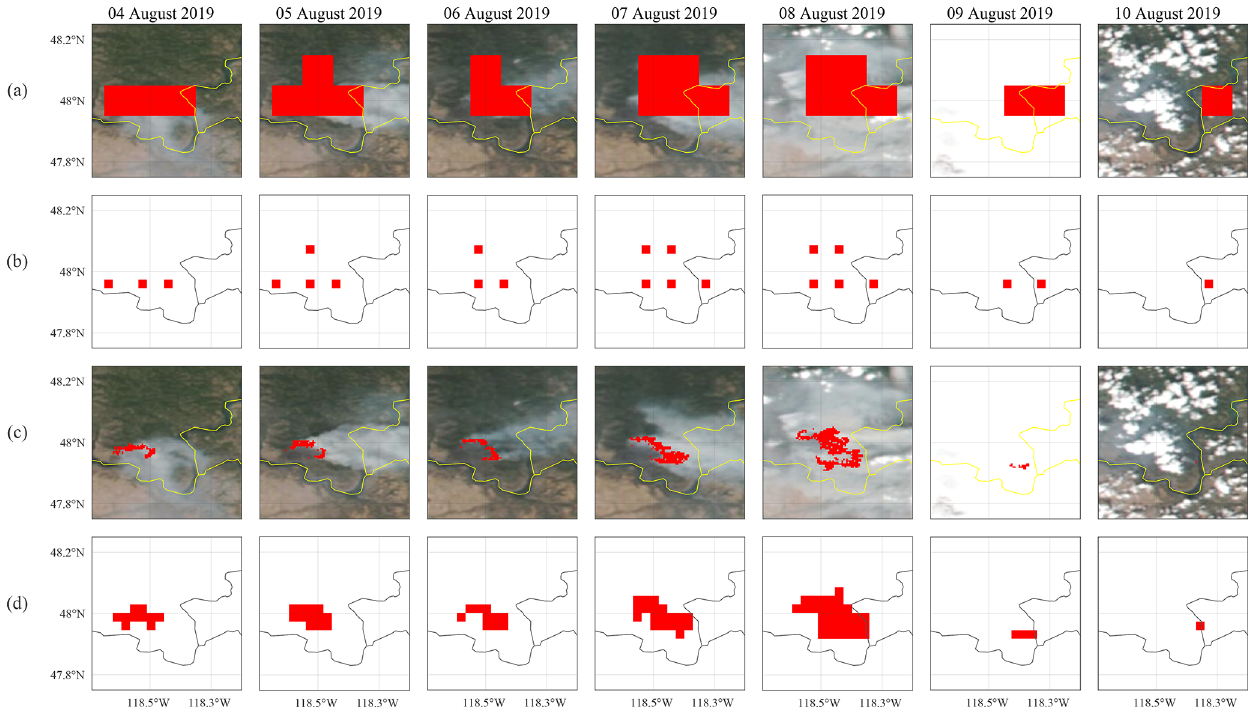
Figure 14. Example of mapping of a large fire event into a high-resolution (3km) model grid. (a) VFEI emissions at 0.1 ◦ resolution. (b) VFEI emissions at 0.1 ◦ resolution mapped into a high-resolution model grid. (c) VFEI at native ∼ 500m resolution. (d) VFEI at native ∼ 500m resolution mapped into the same high-resolution model grid. Each column represents a different day of early August 2019 shown at the top. Panels (a) and (c) include an overlay of VIIRS visible imagery from each day as reference. The VIIRS visible imagery was obtained from NASA Worldview Snapshots (https://wvs.earthdata.nasa.gov, last access: 21 April